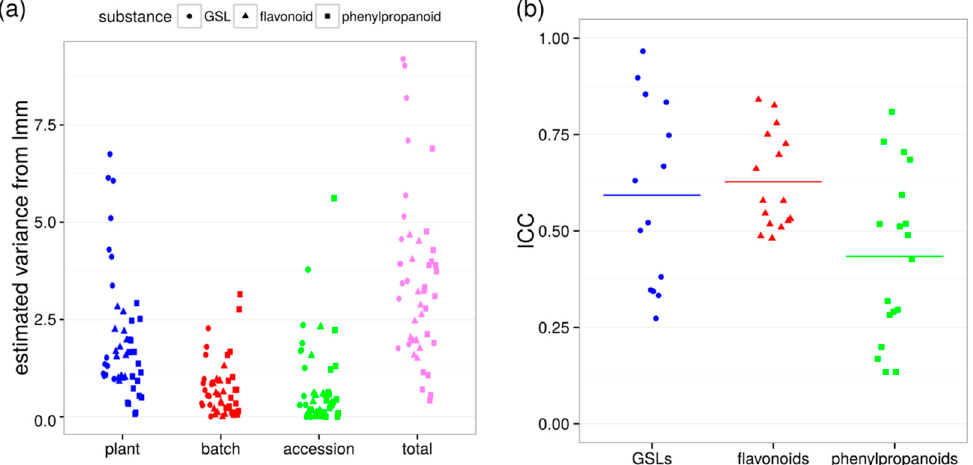
Figure 3. Biological variability of annotated secondary metabolites. ( a ) Variances for plant, batch and accession were estimated with a linear mixed model (lmm), dot—variance of one metabolite; ( b ) ICCs for glucosinolates (GSLs), flavonoids, and phenylpropanoids, dot—ICC of one metabolite, bar—mean ICC for substance class.